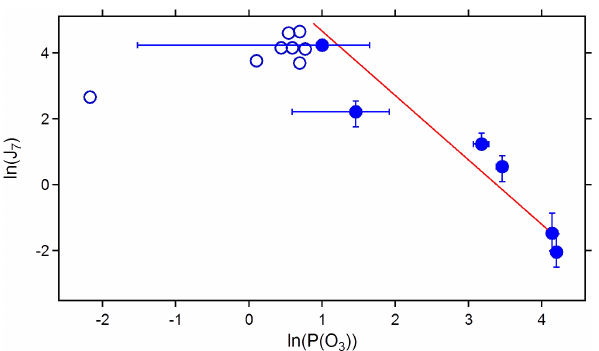
Fig. 10. Double logarithmic plot of J 7 (cm − 3 s − 1 ) vs. P(O 3 ) (ppbh − 1 ) . Open circles are data obtained at P(O 3 ) <2.5ppbh − 1 , closed circles are data obtained at P(O 3 ) >2.5ppbh − 1 . Data pairs with P(O 3 ) <2.5ppbh − 1 were regarded as error prone because P(O 3 ) was calculated to − 0.15 ± 2.5ppbh − 1 when no NO x was added although P(O 3 ) was essentially zero. Therefore linear regres- sion analysis was restricted to data points with P(O 3 ) >2.5ppbh − 1 . The slope of the linear regression line is − 1.6 ± 0.27, R 2 = 0.9. Data points with formally negative P(O 3 ) are not included in the plot. Error bars added only to data points used for the fit. Note that for P(O 3 ) approaching the significance level, the error of the loga- rithm approaches infinity ( ∞